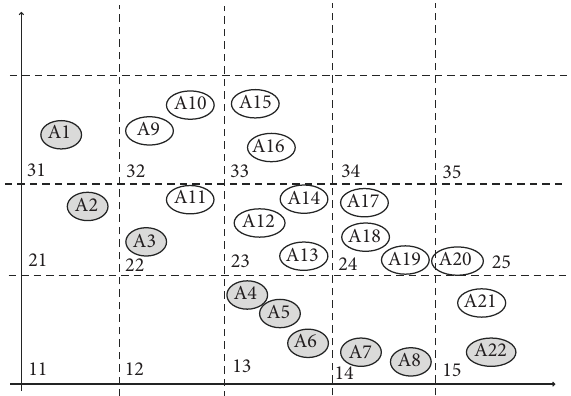
Figure 11: Te view of network search